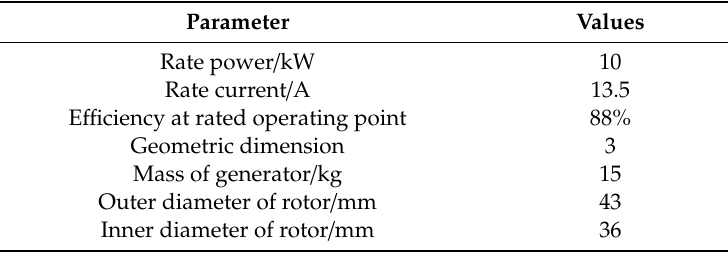
Table 1. Basic parameters of the deflecting-type PMSG.